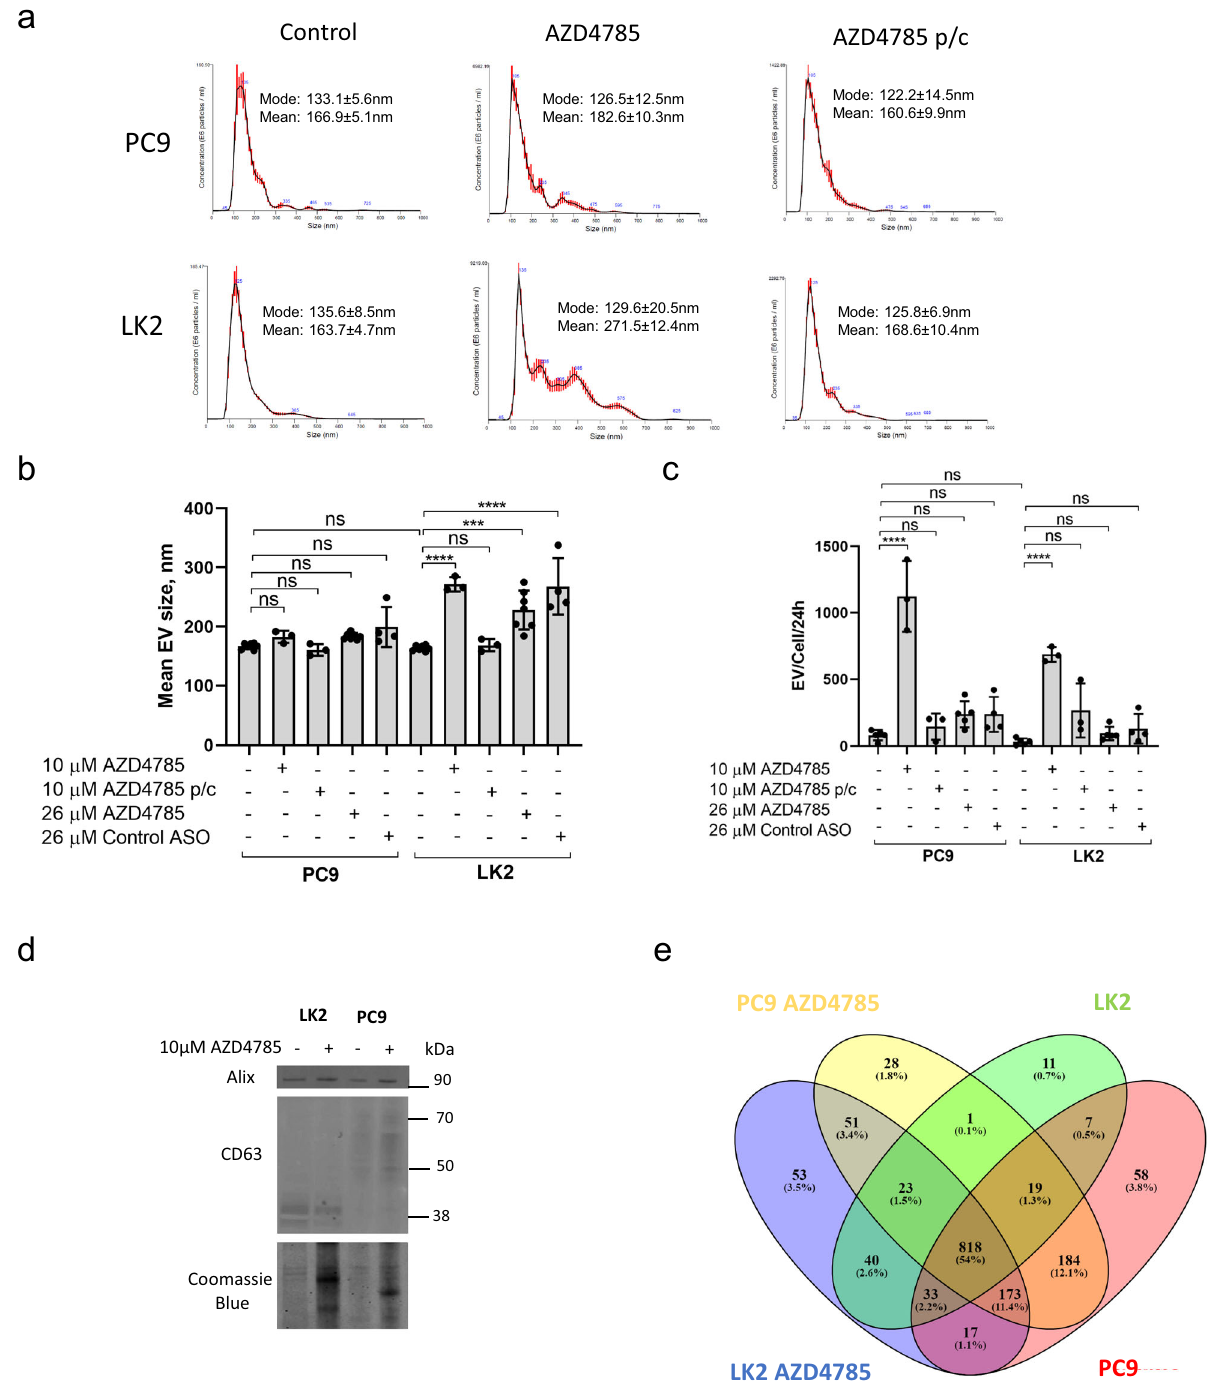
Fig. 3 AZD4785 stimulates EV secretion by PC9 and LK2 cells. a – c PC9 and LK2 were treated with AZD4785 for 24 h. For the pulse-chase (p/c) experiment, cells were treated with 10 µ M AZD4785 for 6 h, washed and incubated for 24 h in the absence of AZD4785 (AZD4785 p/c). EVs were isolated from conditioned cell media by differential ultracentrifugation and a 100,000× g pellets were analysed by NTA. Representative NTA images. ( N = 6). b Size distribution of EVs secreted by PC9 and LK2 cells. EVs were collected and analysed as in a . Error bars, standard deviation. ANOVA **** p < 0.0001. *** p < 0.001. ns non-signi fi cant. N = 3 – 6. c Quanti fi cation of EV secretion by PC9 and LK2 cells. The total number of EVs was measured by NTA as in a and divided by the total number of cells. Error bars, standard deviation. ANOVA. **** p < 0.0001, ns non-signi fi cant. N = 3 – 6. d Detection of exosomal markers, CD63 and Alix, in EVs isolated from PC9 and LK2 cells after 24 h treatment. Equal aliquots of EVs isolated as in a were analysed by western blotting and probed for CD63 and Alix. Representative image from N = 2. e Vein diagram for the EV ’ s protein mass spectrometry analysis revealed differentially secreted protein in PC9 and LK2